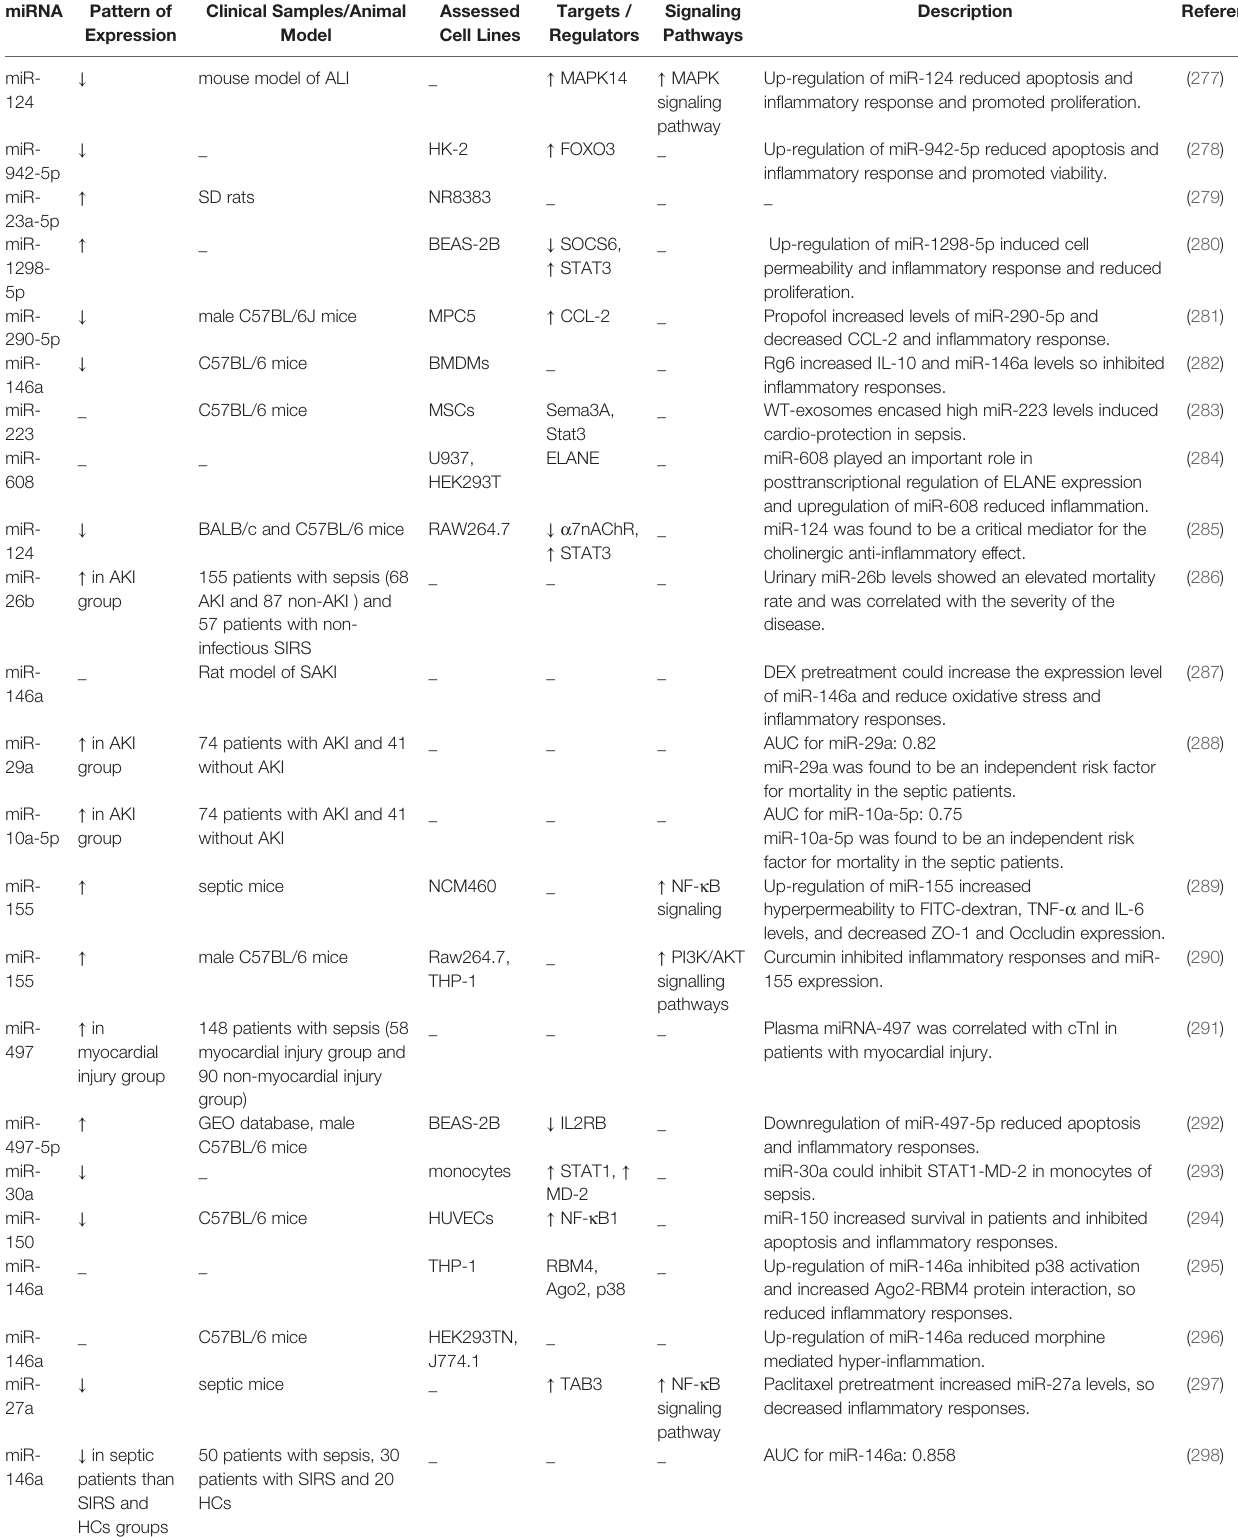
50 patients with sepsis, 30 patients with SIRS and